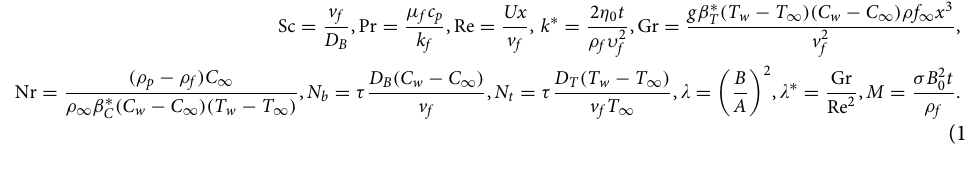
Initial and boundary conditions in Eq. (6) transform into the following form